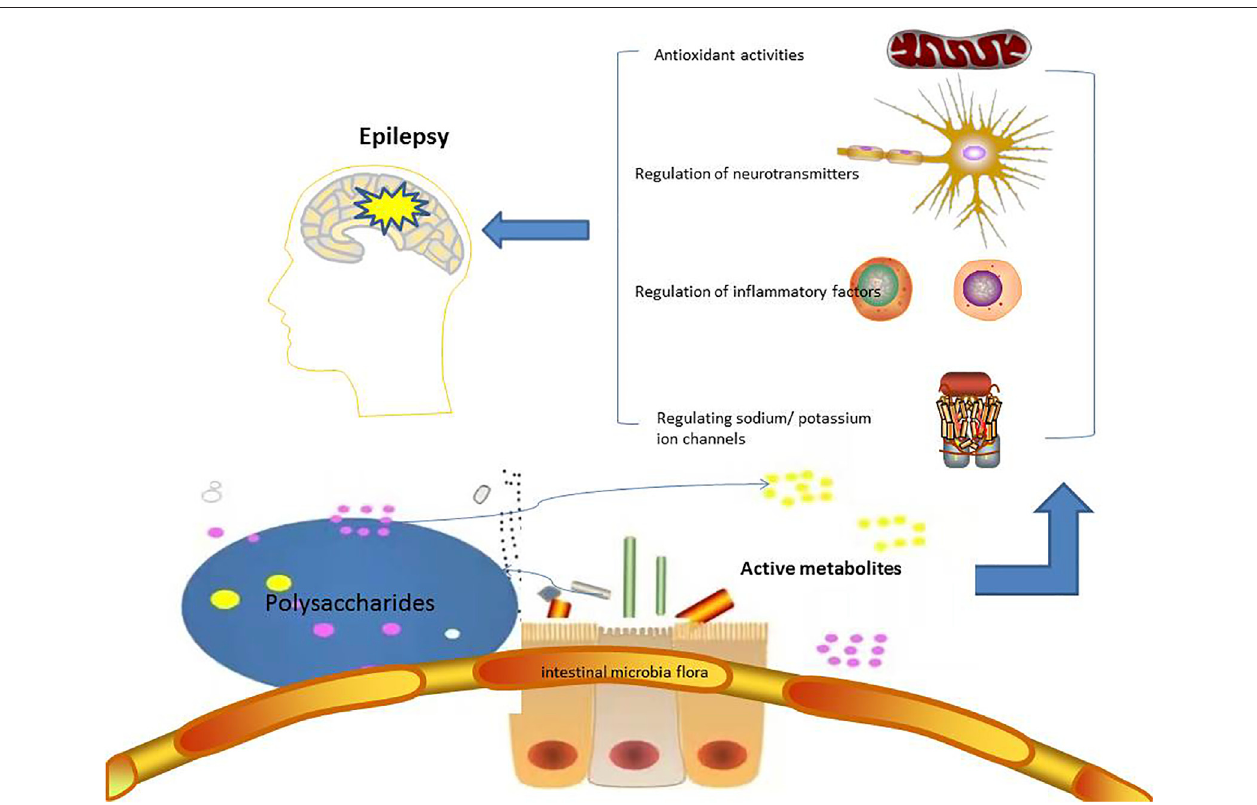
FIGURE 1 | The potential anti-epileptic mechanism of polysaccharides targeting on gut microbiota. Polysaccharides are degraded into active metabolites by gut microbiota, and then to treat epilepsy in the ways of regulating in fl ammatory factors, neurotransmitters, ion channels, and antioxidant activites.